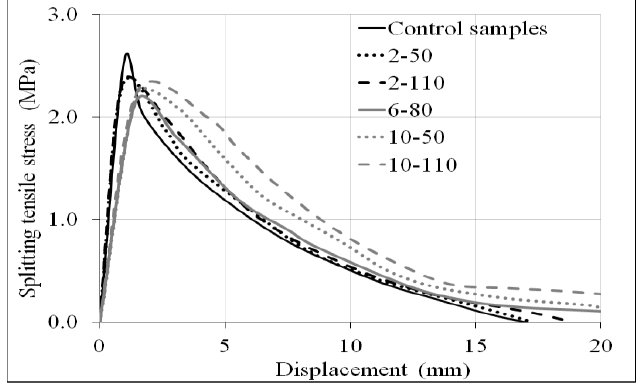
Figure 11. Splitting tensile stress-displacement curves of control samples and concrete with recycled PET fibres.